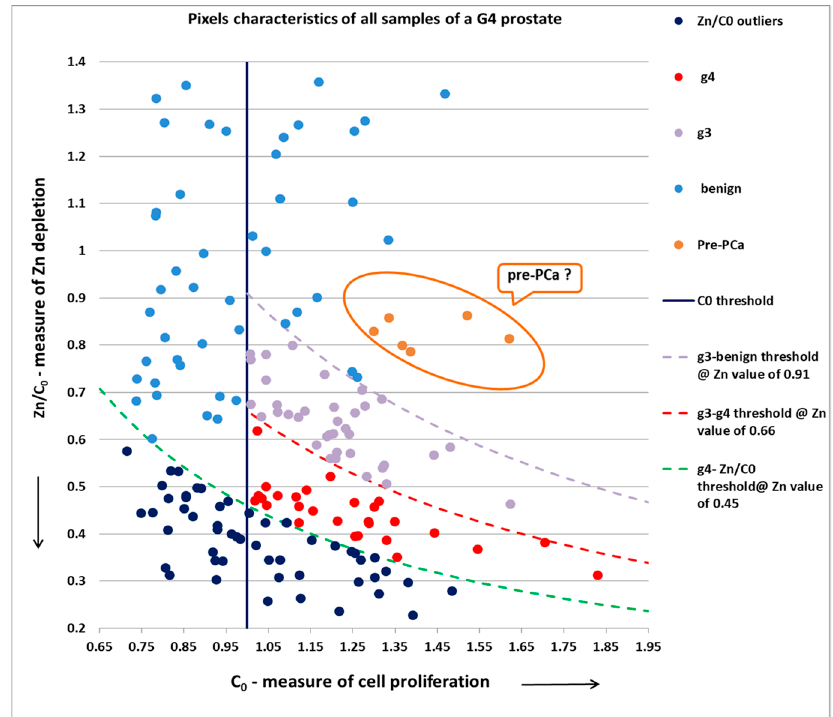
Figure 5. Pixel characteristics and thresholds in a high-PCa-malignancy-score G4 prostate (one single benign sample, and several g7 (3 + 4), g7 (4 + 3) and g8 (4 + 4); pixels: benign, g3 and g4).